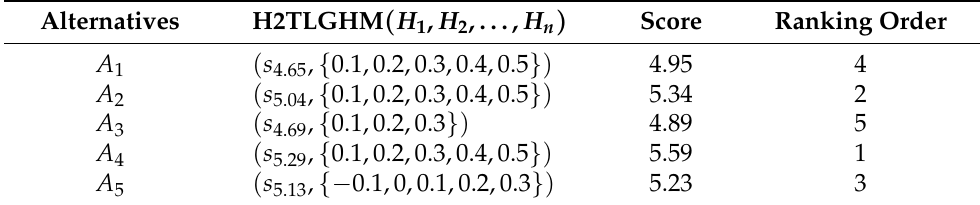
Table 11. Ranking of alternatives by using H2TLGHM operator when p = q = 1.